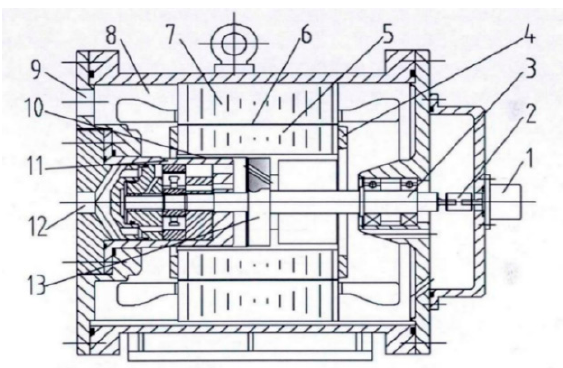
Figure 2. The hydraulic motor vane pump designed by Ji Hong.